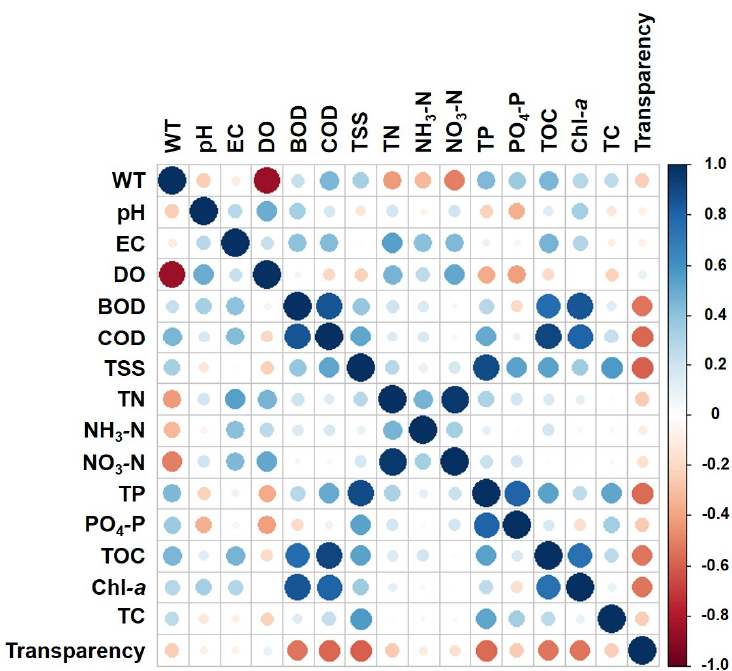
Figure 2. Pearson correlation matrix between physicochemical and biological parameters in the PDR.